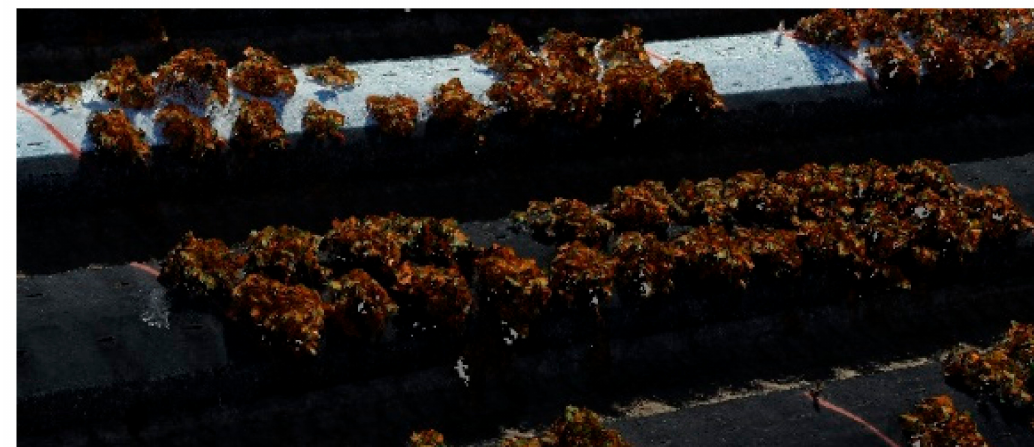
Figure 4. Dense point cloud of the surface created from overlapping RGB and IR images. A 2 mm DSM representing the relief of the objects (canopies, plants, and soils) [19] was created for each image acquisition date. Similarly, a 1 mm orthorectified mosaic (orthomosaics) free from the geometric distortion caused by topographic relief and camera tilt [20] was created for each of the RGB and IR bands. The DSM and orthomosaics were then used to derive strawberry vegetation masks and to extract canopy structural properties, such as canopy area and volume using the ESRI ArcMap (v 10.3) [21] software. Visual interpretation was used to identify and count strawberry fruits and flowers visible in the images. Although seven different fruit development stages were used as described in Figure 5, they were grouped into just two categories (flowers and fruits) for this study (Figure 5). The fruits and flowers were identified in the individual images and their locations on the orthomosaic were marked using ESRI ArcMap software. These point locations were aggregated to compute the flower and fruit counts at the plot level.